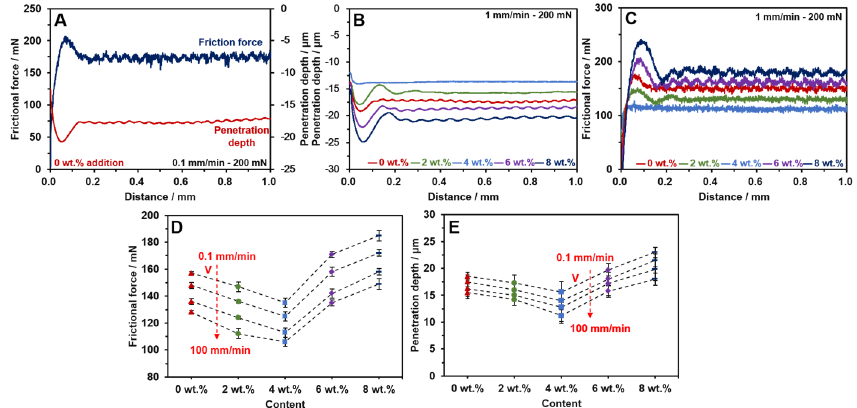
Figure 5. Frictional responses of the HDPE composites with different Si 3 N 4 contents: ( A ) penetration depth and corresponding frictional force; ( B ) penetration depth and ( C ) frictional force with increasing applied loads; ( D ) averaged frictional force and ( E ) penetration depth under different scratching velocities.